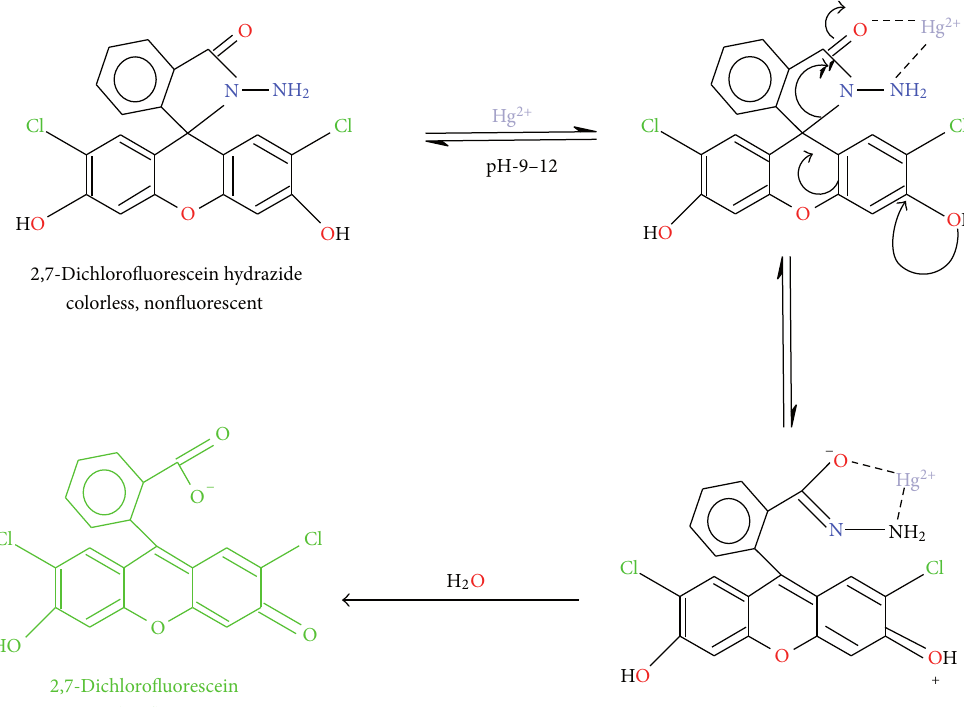
S 2: Schematic representation of mechanistic pathway of 2,7-dichloro�uorescein hydrazide and its reaction with mercury